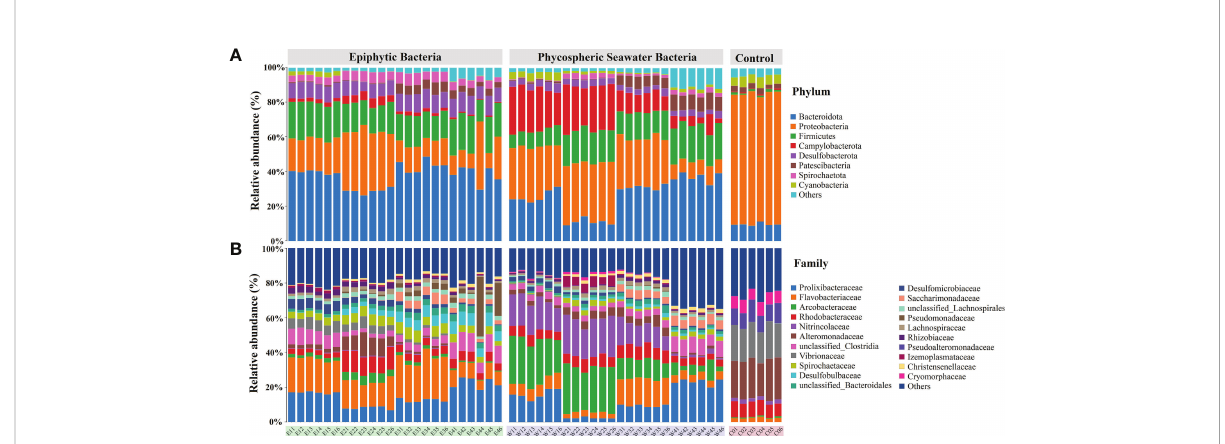
FIGURE 4 Taxonomic composition of bacterial communities. The histograms show the phyla (A) and families (B) with relative abundance above 1.00%. E and W refer to the epiphytic and phycospheric seawater bacterial sample groups, respectively. The numbers 1 to 4 refer to the P1 to P4 phases, respectively. C0 refers to the control seawater bacterial sample groups. Others: sum of taxa with a relative abundance below